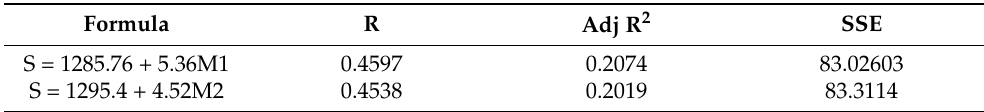
Table 5. Regression formulae for unknown sex with its correlation coefficient (R), adjusted determi- nation coefficient (Adj R 2 ), and standard error of estimate